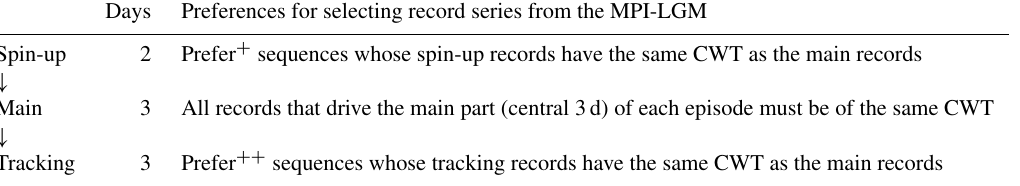
Table 1. Temporal concept for the episodic 8d WRF-Chem-LGM simulations performed to reconstruct the LGM dust cycle based on statistic dynamic downscaling. As the MPI-LGM contains fewer than 13 separate 8d record sequences for a few CWTs, some of the episodes were driven by a heterogeneous sequence of records. That is, one (or more) of the records in these sequences differs in its CWT from the CWT of the records for the main days. For selecting heterogeneous sequences, the CWT correspondence between the main and tracking records is considered higher priority ( = ++ ) than between the main and spin-up records ( = + ).